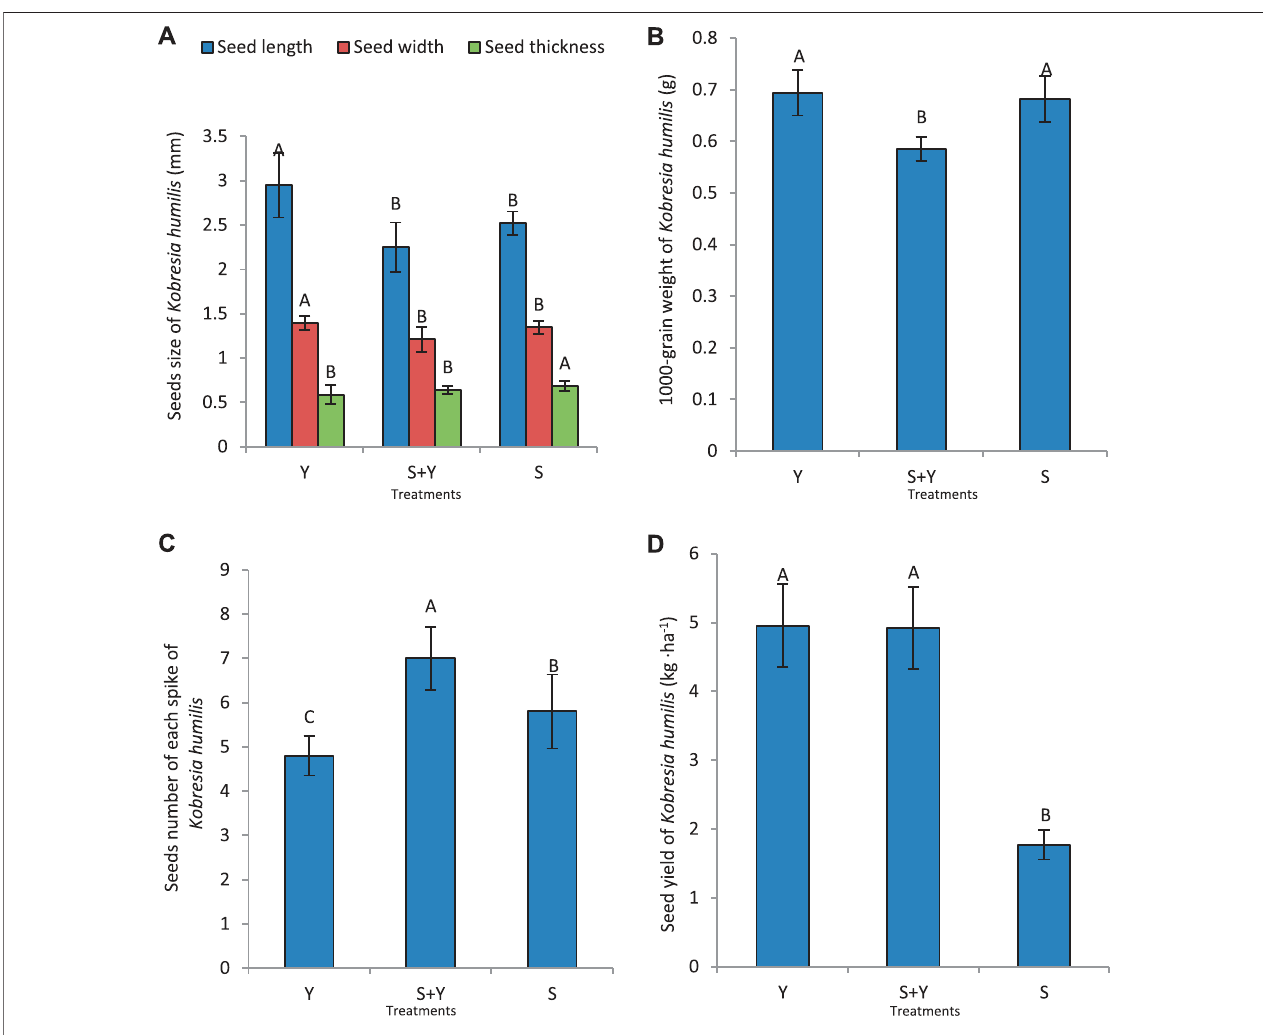
FIGURE6| Effectsofgrazingmethodsonseedindicatorsof K.humilis : (A) seedsize, (B) 1000-seedweight, (C) seednumberperspike,and (D) seedyield.Capital letters indicate signi fi cant differences between grazing methods ( p < 0.05).